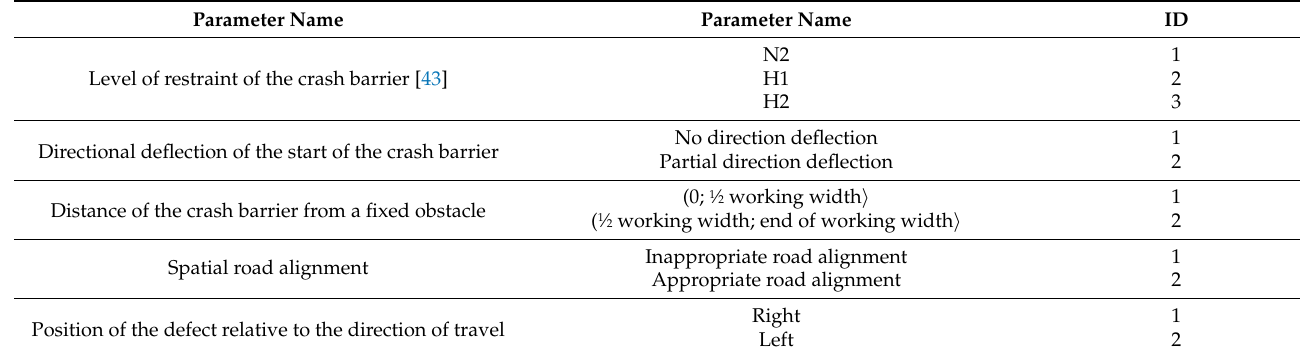
Table 2. Numerical indication of the value of selected